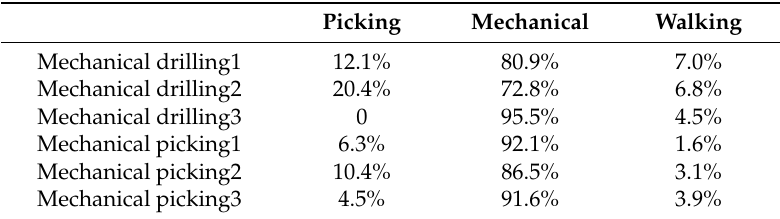
Figure 14. The identification results of mechanical picking signals. ( a ) The first group of mechanical picking signals; ( b ) The second group of mechanical picking signals; ( c ) The third group of mechanical picking signals. Table 2. The identification rate of Mechanical signals.